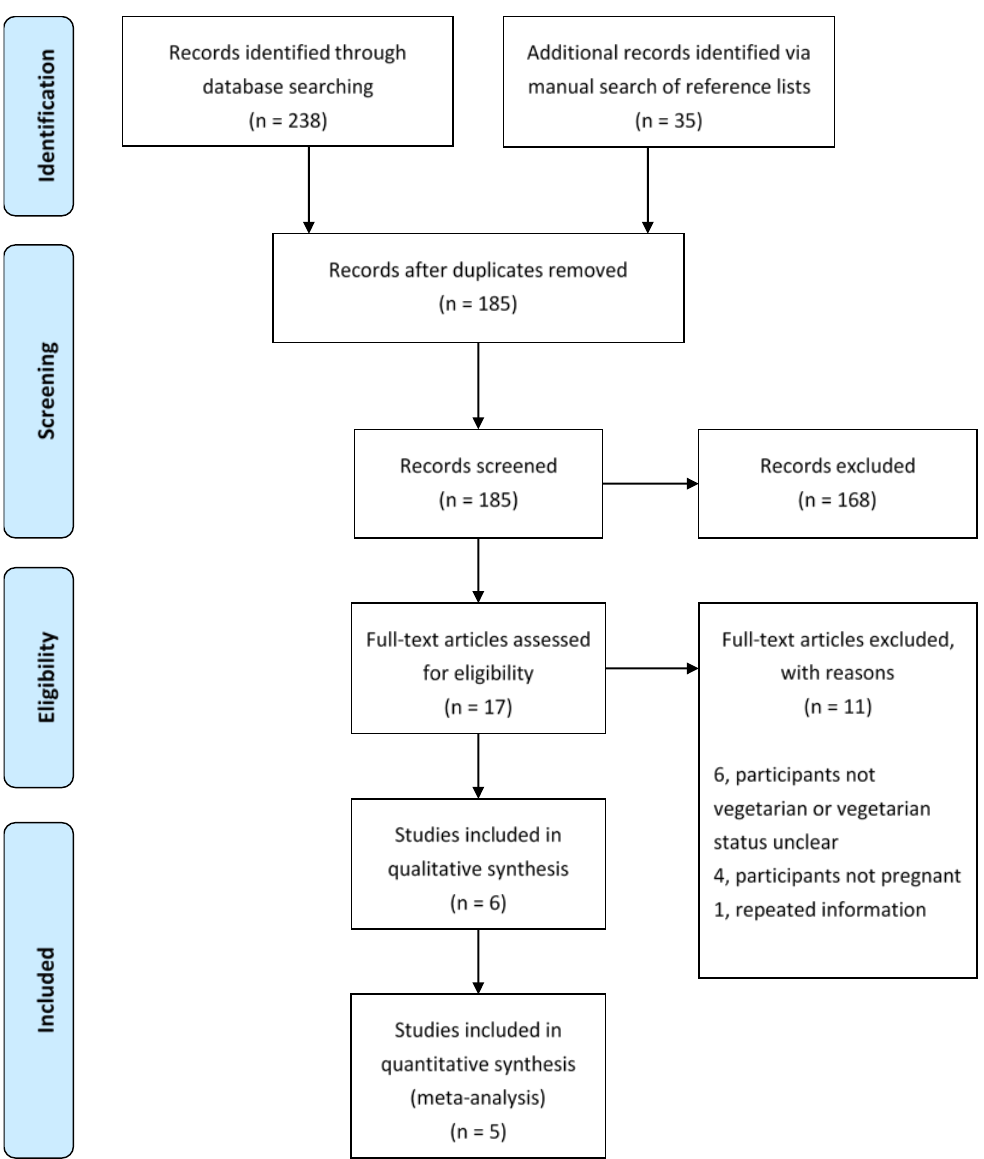
Figure 1. Flowchart detailing identification and selection of studies for inclusion in the review